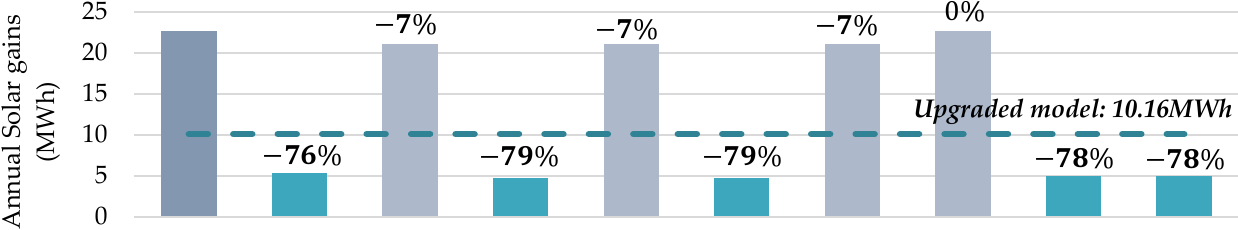
Figure 18. Solar gains of the retrofit packages.